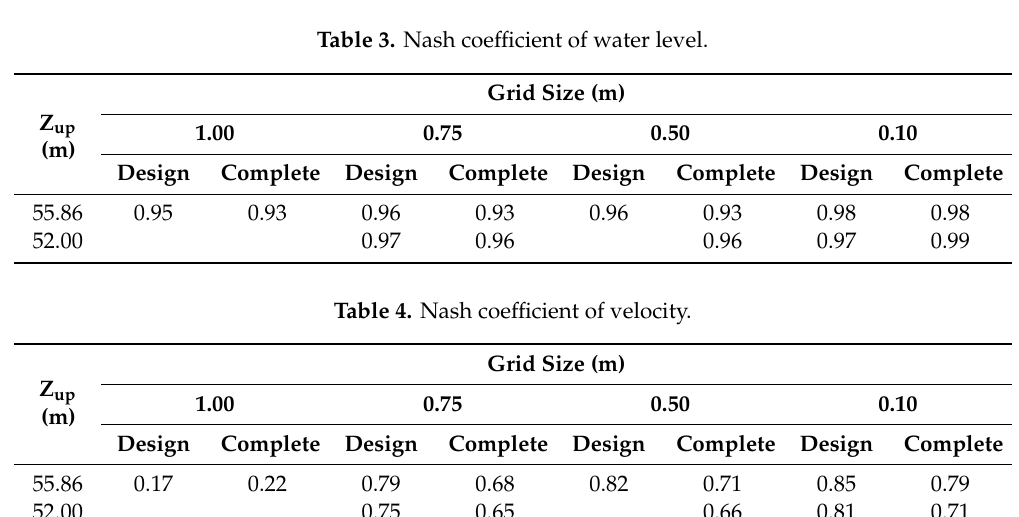
Figure 10. Void fraction in case of Z up = 52 m. The water elevation and velocity were measured using five guages, and one phase water and two phase water–gas flow data were compared with the measured data (Figure 11). There is no significant difference between the water levels calculated by both scenarios, except at the second gauge, where the flow is strongly fluctuated because of the oblique waves after piers. The velocity results measured by the RANS model and air entrainment model are closest to the empirical solution, except in the case of gauge 4. At gauge 3, the relative error yeilded by RANS and air entraintment models was 0.83% in comparison with 4.5% of the result calculated by only turbulent one.